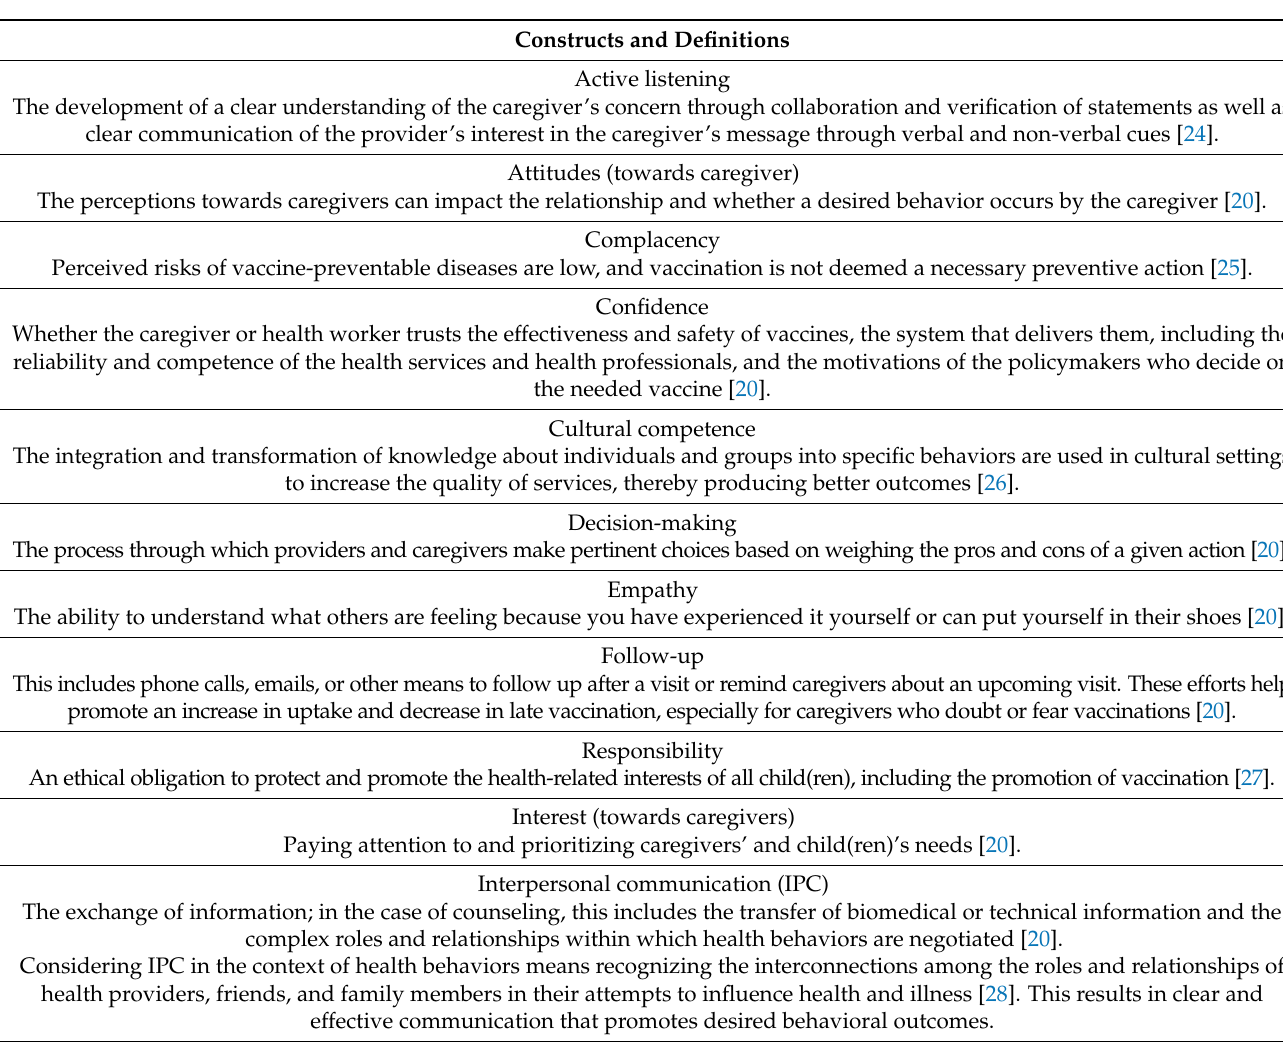
Table 1. Provider construct